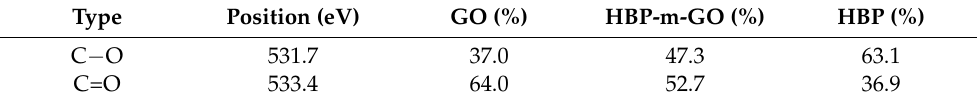
Table 1. Detailed analysis of the O 1s profile of XPS results of GO, HBP-m-GO, and